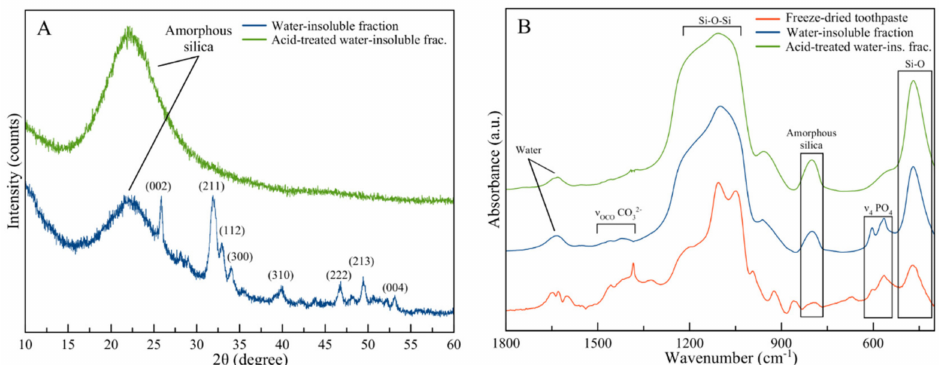
Figure 2. ( A ) Powder X-ray di ff raction (PXRD) patterns and ( B ) Fourier transform infrared (FTIR)–attenuated total reflectance (ATR) spectra of the total toothpaste, the water-insoluble fraction, and the acid-treated water-insoluble